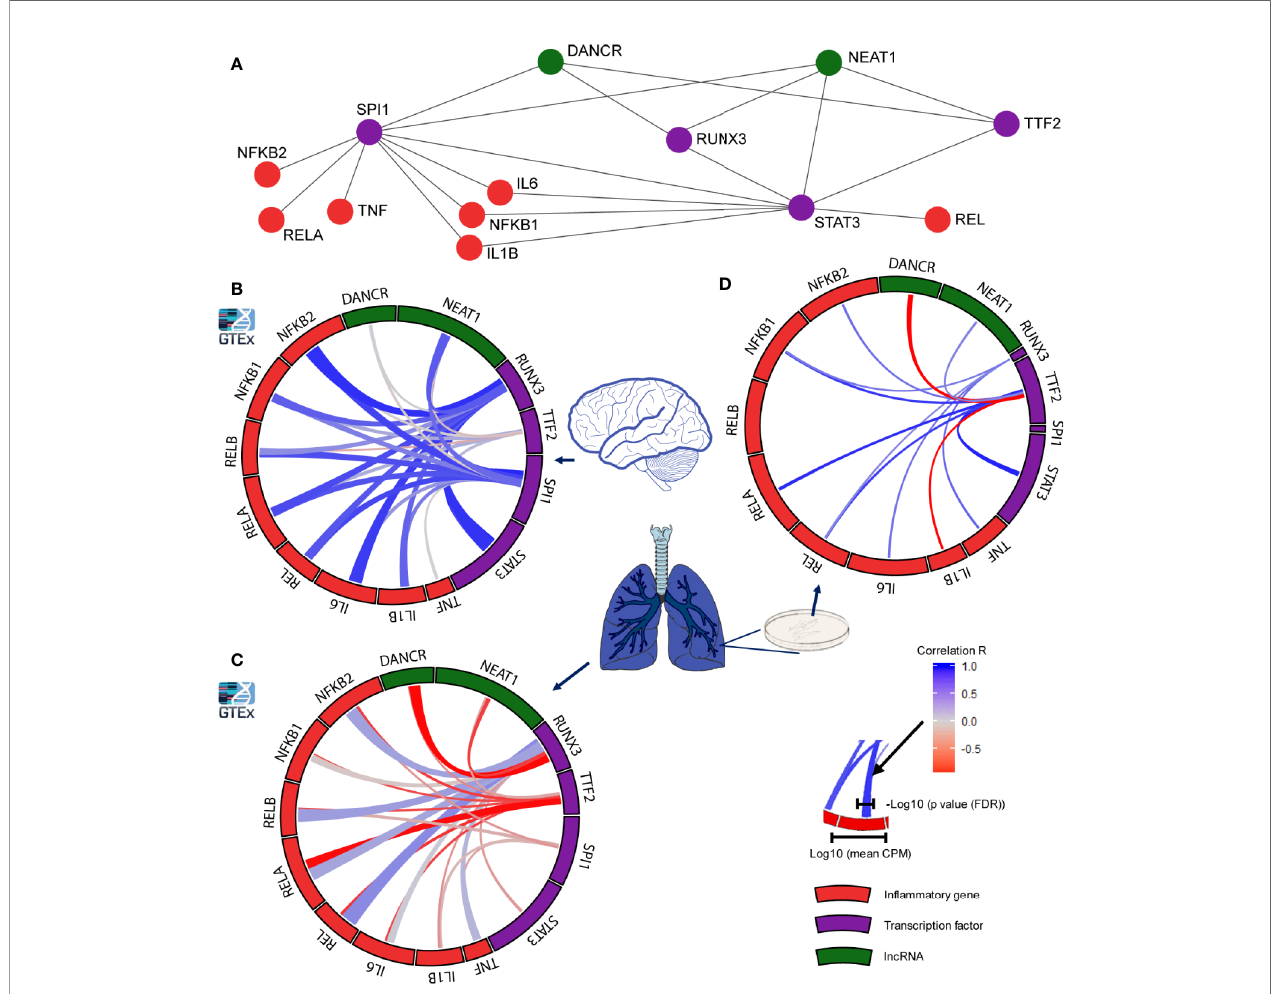
FIGURE 4 | Distinct transcription factors affect the infection-related brain and lung impact of DANCR, NEAT1 and in fl ammatory transcripts. (A) Network presenting links of DANCR and NEAT1 (green) and in fl ammatory genes (red) with the transcription factors (TFs; purple) controlling their expression. (B) correlation between the expression levels of the various TFs to in fl ammatory (red) or lncRNA (green) transcripts in cortex samples from 158 post-mortem GTEx donors. The width of the bars on the surrounding circle represent log10 of the transcript ’ s CPM, the width of the tracks connecting the genes represents -log10 of the FDR corrected p value of the correlation between the two connected genes, and the color intensity of the track represents the correlation R (blue — positive and red — negative correlation). (C) As in B but for 427 lung samples. (D) As in B but for Calu-3 lung epithelial cell (from GSE148729;